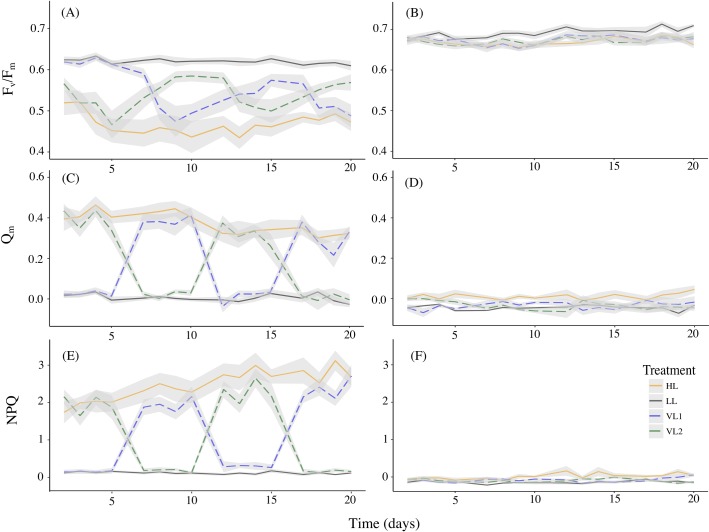
Photosynthetic potential, light stress and non-photochemical quenching under constant high and low DLI, and under two variable DLI treatments.Mean maximum quantum yield (Fv/Fm), excitation pressure on PSII (Qm) and non-photochemical quenching (NPQ) of Pachyseris speciosa (A, C, E)—and Acropora millepora (B, D, F), over the 20-days experiment in high DLI treatment (HL, orange), low DLI treatment (LL, purple), variable DLI 1 treatment (VL1, blue dashed lines) and variable DLI 2 treatment (VL2, green dashed lines). Values represent means over 16 colonies per treatment per species, with shaded areas representing standard error.